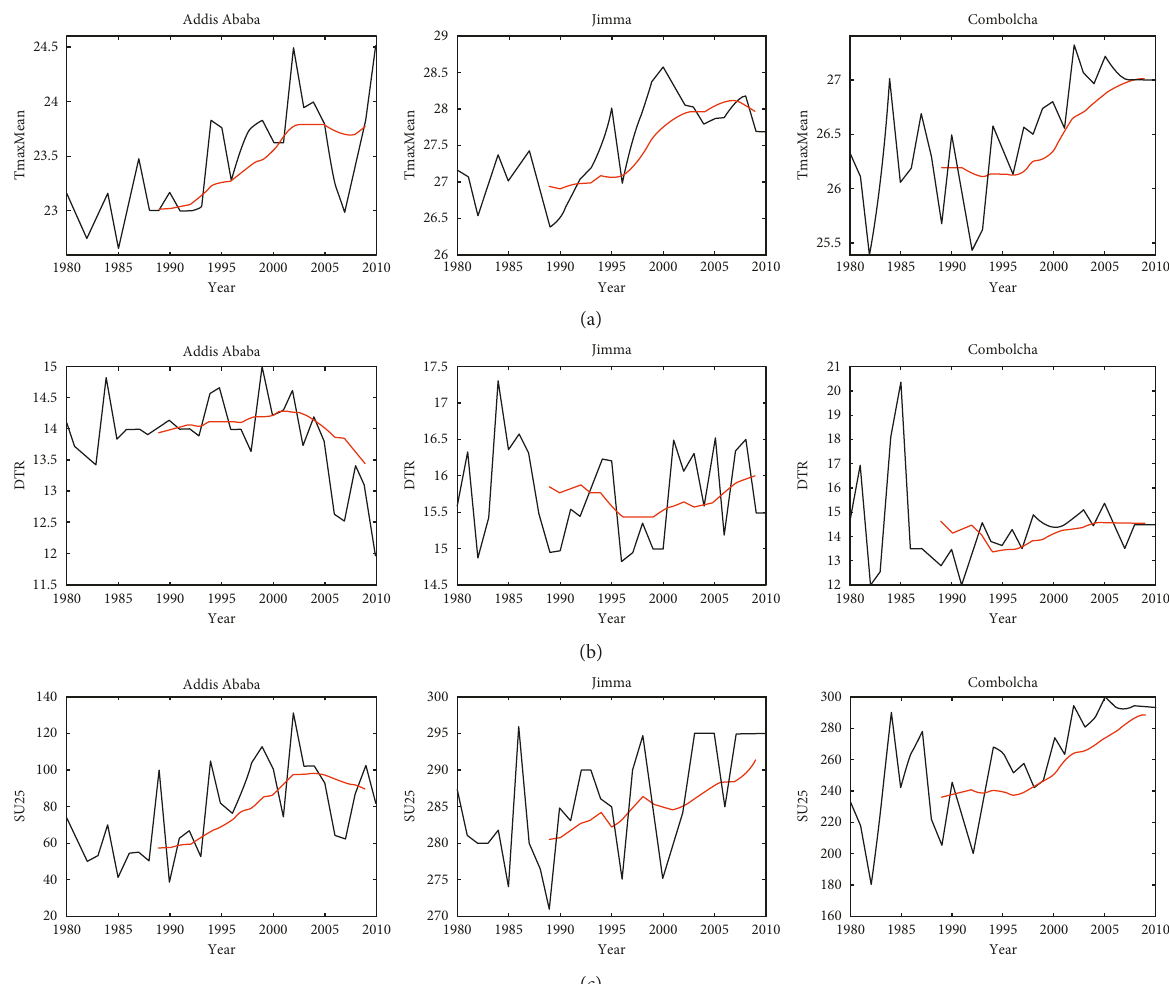
Figure 7: Ten-year moving average (red line) and time-series plot of TMAXmean (a), DTR (b), and SU25 (c) of temperature